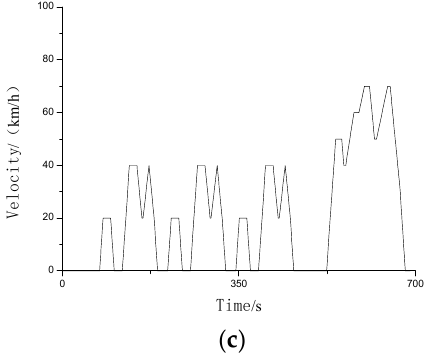
Figure 8. Typical urban road conditions: ( a ) ECE, ( b ) UDDS, ( c ) 1015.